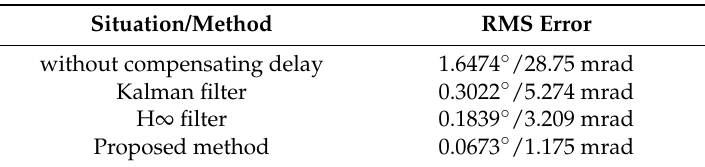
Table 1. Tracking accuracy comparison.